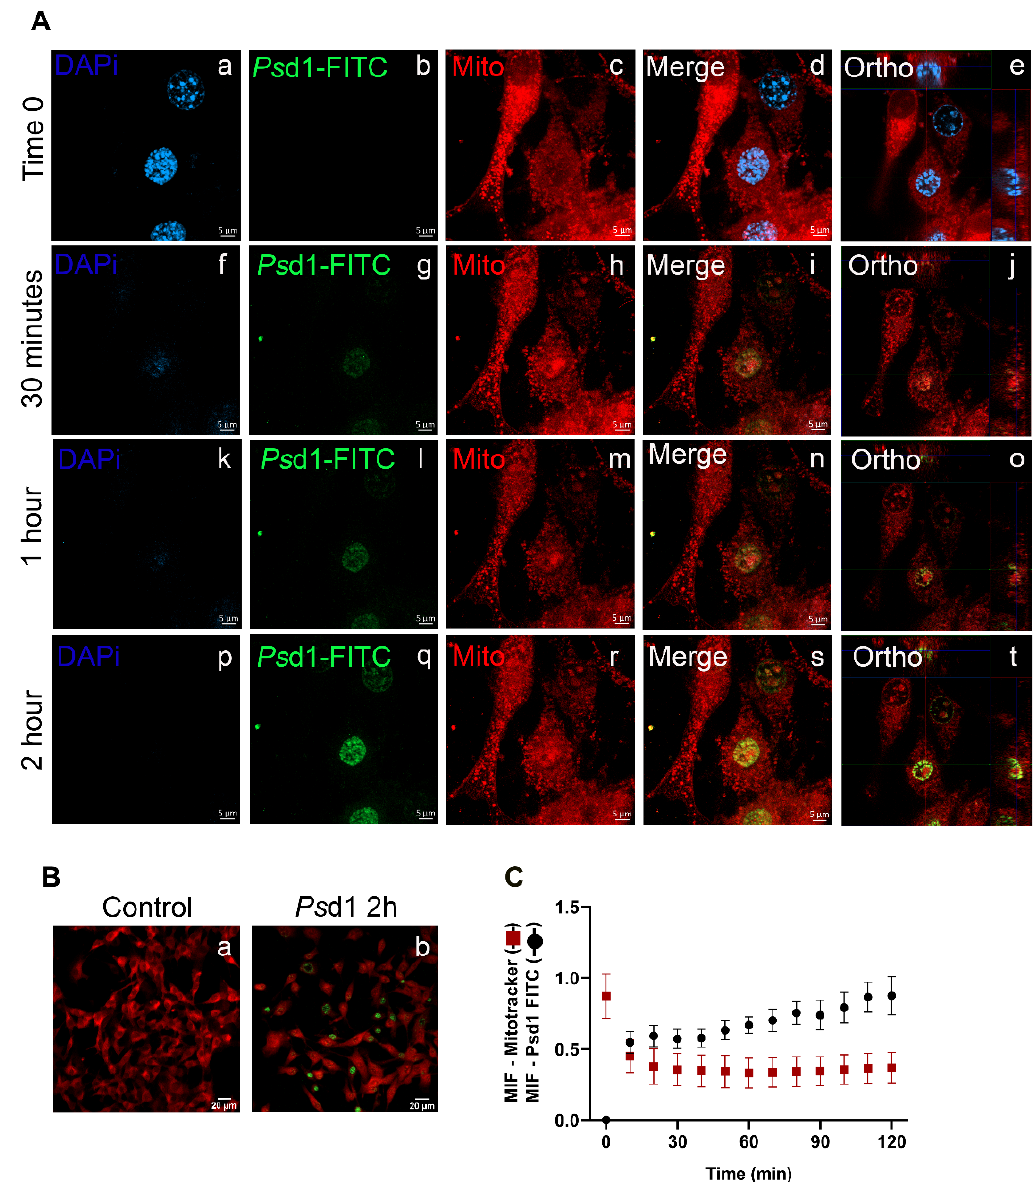
Figure 3. Fluorescein isothiocyanate (FITC)- Ps d1 was localized in the B16F10 live cell nucleus. ( A ) B16F10 cells (1.5 × 10 4 ) were initially pre-stained with DAPI and MitoTracker Red CMXRos followed by the addition of 9 µM Ps d1-FITC. Images were acquired in real time every 10 min for two hours at 100× magnification. ( B ) B16F10 cells in the absence of Ps d1 (control time zero) and in the presence of 9 µM Ps d1 for two hours ( Ps d1 2h) at 10× magnification. ( C ) The mean fluorescence intensity (MIF) of MitoTracker and FITC- Ps d1 labeled cells measured over time. Average values with standard deviation (SD) of two independent experiments are reported.